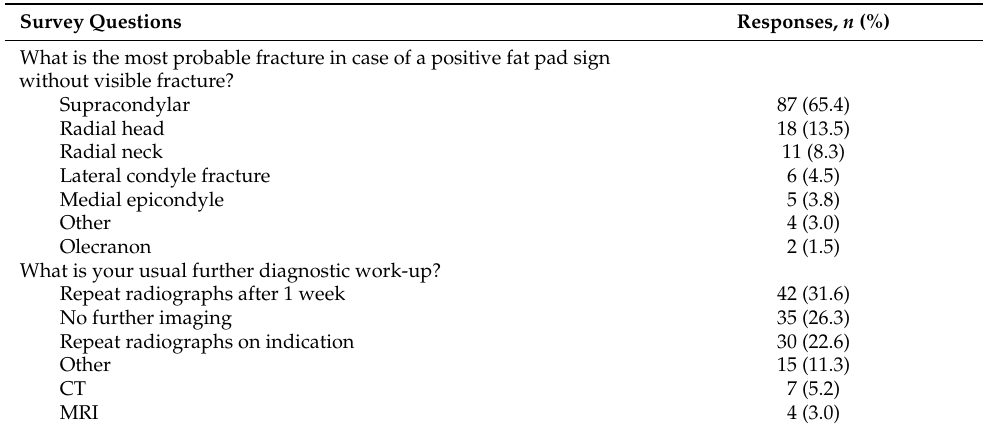
Table 2. Diagnosis and treatment ( n =